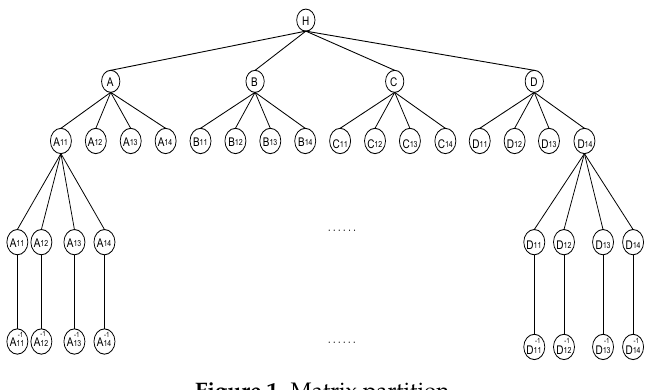
Figure 1. Matrix